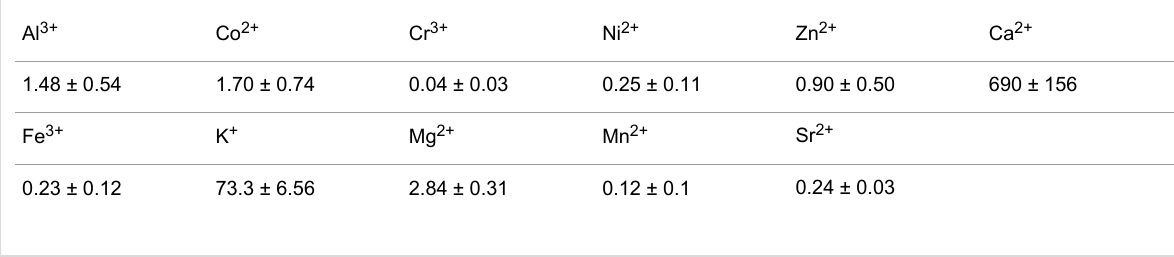
Table 3: Average concentrations expressed in mg·L − 1 and standard errors of the main elements present in the DWs ( n = 5).